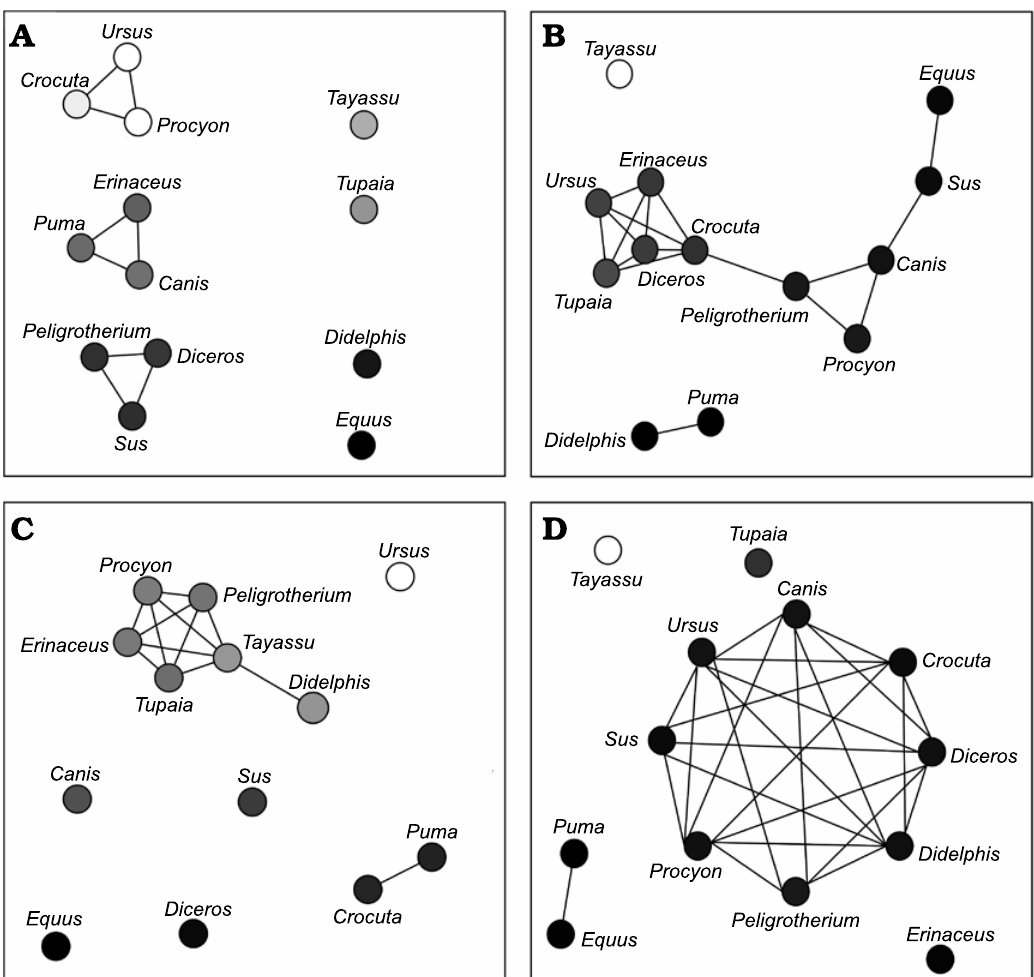
Fig. 10. Connectivity graphs summarizing the results of pairwise randomization tests performed on the per-vertex values of orthal bite force (BF) dif- ferences. Lines connect taxa that are not found to be significantly different, and gray-scale value of individual nodes are proportional to the value of the parameter tested (e.g., dark tones are lower in value, and higher values are closer to white). A . Graph summarizing pairwise significance tests of mean Group 1 (G1) minus Group 2 (G2) orthal BF. B . Graph summarizing pairwise significance tests of F-value (variance ratio) of G1 minus G2 orthal BF. C . Graph summarizing pairwise significance tests of mean closed gape minus open gape orthal BF. D . Graph summarizing pairwise significance tests of F-value (variance ratio) of closed gape minus open gape orthal